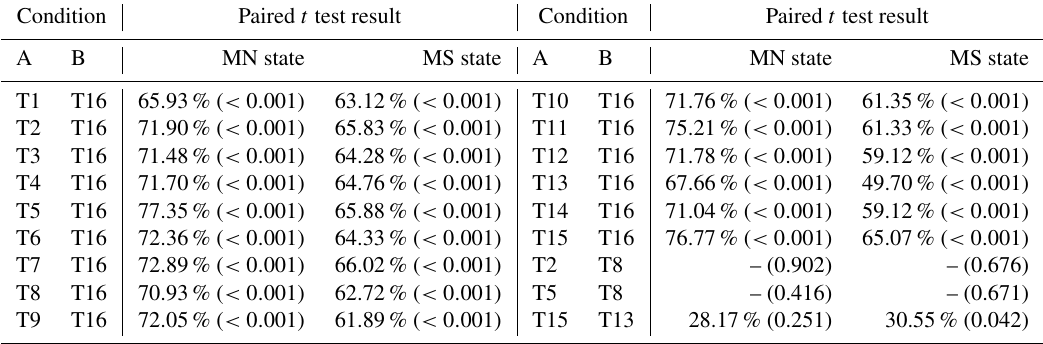
Table 4. Paired t test results for the MN and MS states. Condition Paired t test